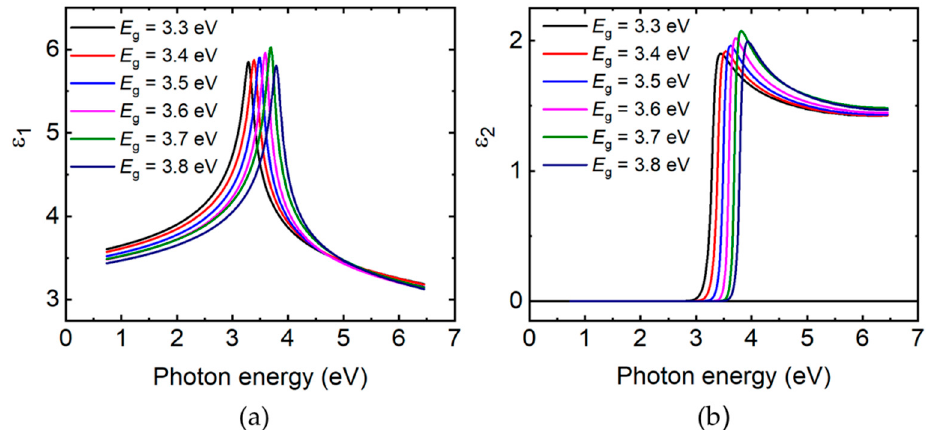
Figure 6. Analytically determined complex dielectric function ( ε = ε 1 − i ε 2 ) spectra for hypothetical Mg x Zn 1 − x O films with different Mg contents x and bandgap energies E 0 = E g . ( a ) photon energy of ε 1 ; ( b ) photon energy of ε 2 . These spectra were determined from Equations (1) and (2) using the bandgap and linked E t value, seven fixed parameters, and four polynomial descriptions as presented in Table 2. The polynomial expressions in Table 2 enable linking the additional four parameters to the bandgap, enabling the dielectric function spectra to be specified by the single bandgap variable. As the CP amplitude increases with x for x < 0.30, both the bandgap CP